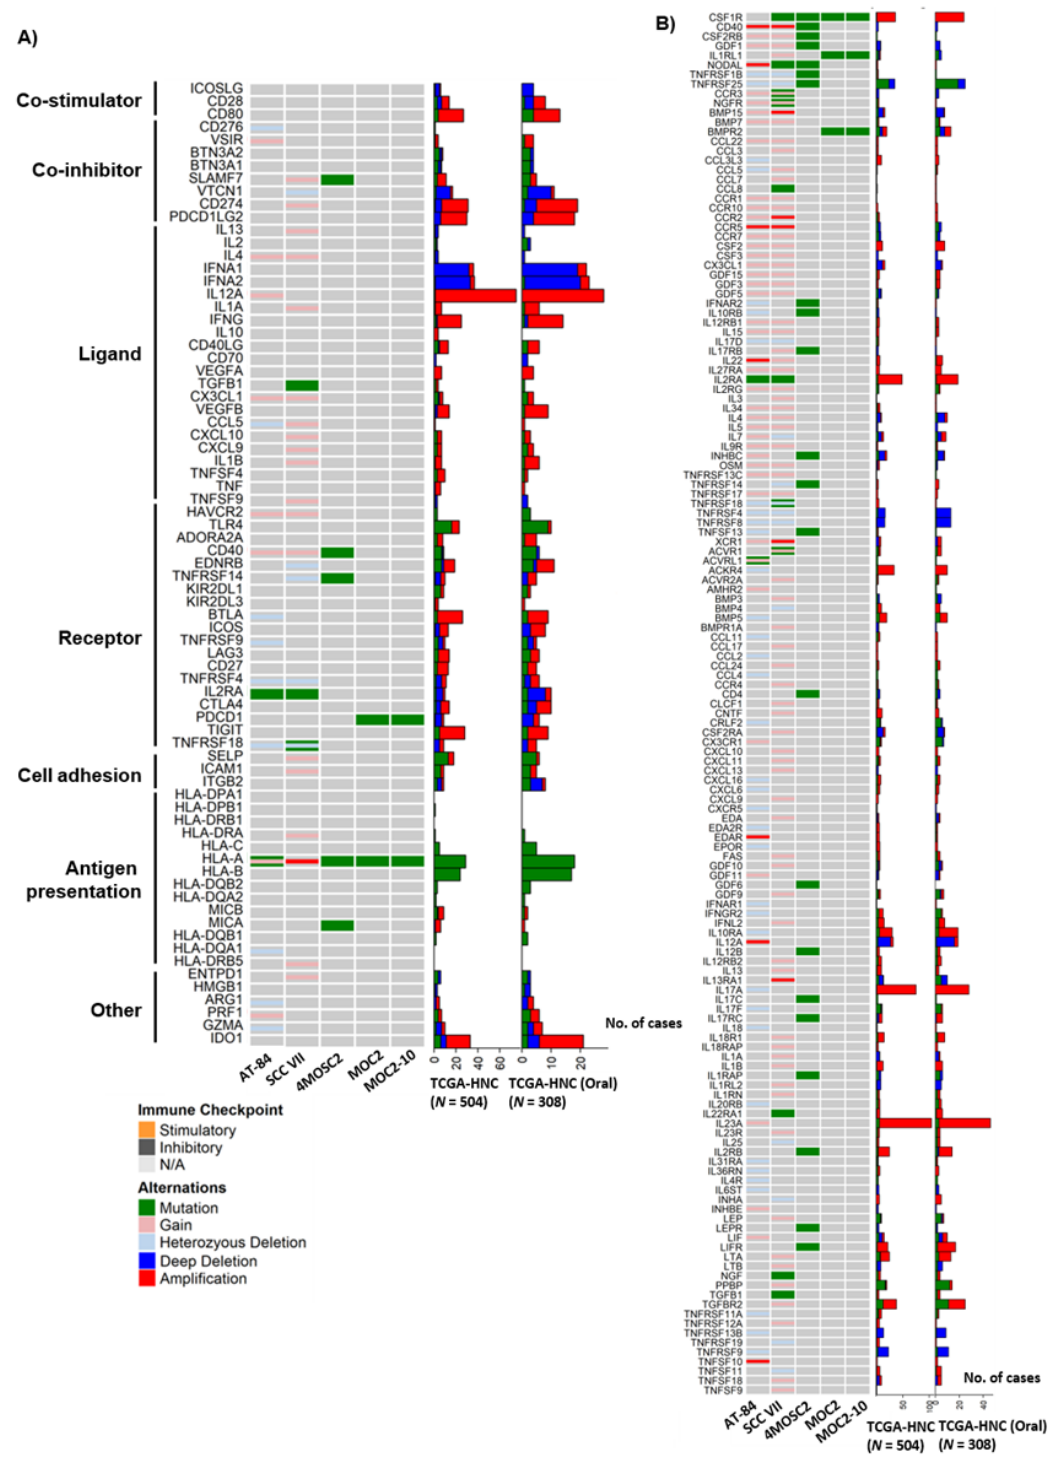
Figure 5. Genetic aberrations of immune-related genes in 5 mouse models vs. HNC patient tumors ( N = 510). ( A ) Oncoprints showing mutational and copy number alterations of immunomodulators of 5 mouse models vs. TCGA-HNC patient tumors as well as TCGA-HNC oral tumors. ( B ) Oncoprints showing mutational and copy number alterations of cytokine–cytokine interaction molecules in 5 mouse models and corresponding genetic aberrations in TCGA-HNC patient tumors and TCGA-HNC oral tumors.